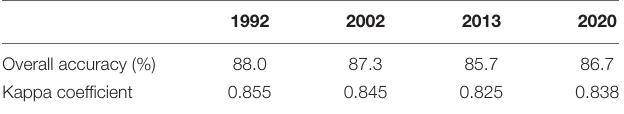
TABLE 3 | Image classification accuracy